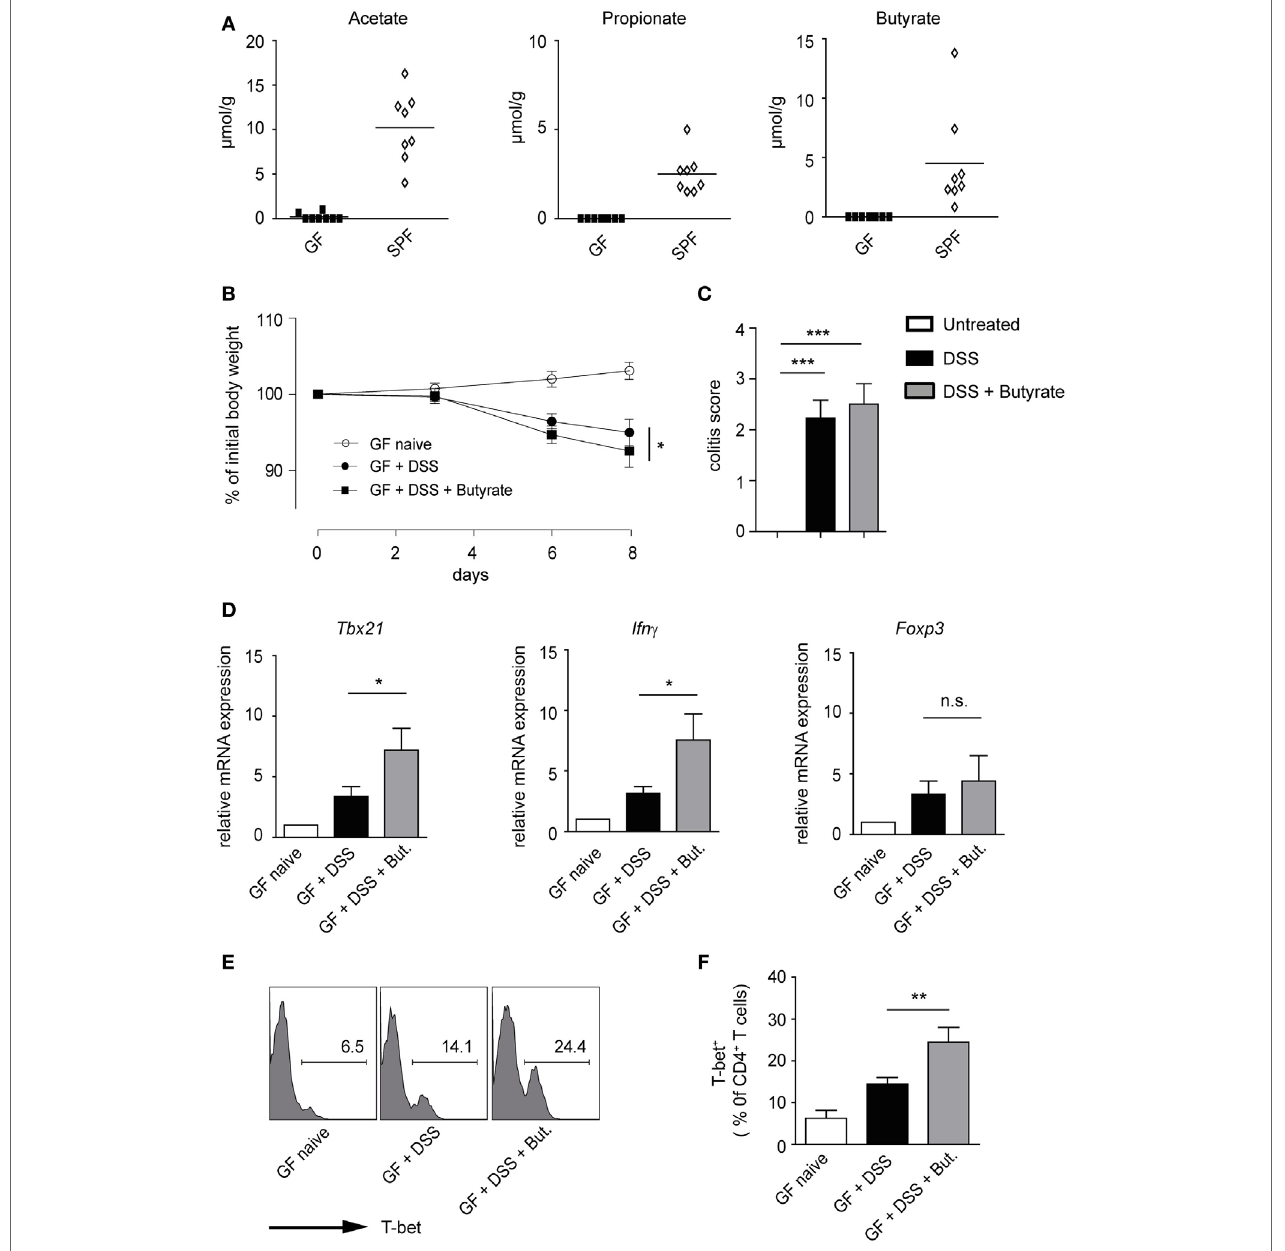
FigUre 6 | Impact of butyrate treatment on colonic acute inflammation in germ-free (GF) mice. (a) Short-chain fatty acid concentrations in colonic luminal content of GF and specific pathogen-free mice measured with ultra-high performance liquid chromatography–mass spectrometry. (B,c) GF mice were orally pretreated with 100 mM sodium butyrate for 3 weeks. Afterward, 1.5% DSS was given into drinking water for 5 days in the presence or absence of 100 mM butyrate. Changes in initial body weight (B) and determination of colitis score (c) on day 8 after DSS treatment are shown ( n = 6 mice per group). Bars (C) represent the mean ± SEM; * P = 0.01–0.05, *** P < 0.001. (D) Acute colitis was induced in GF mice as described above. The colonic mRNA expression of Tbx21 , Ifn γ , and Foxp3 was analyzed on day 8 after colitis induction by qRT-PCR ( n = 6 mice per group). Results are displayed as the mean ± SEM; * P = 0.01–0.05, n.s., not significant. (e,F) The percentages of T-bet + cells within colonic CD4 + T lymphocytes on day 8 after induction of colitis in the indicated groups. Histograms (e) are representatives of two similar experiments showing the frequency of T-bet + in CD4 + gate. Data (F) are presented as mean ± SEM, ** P =